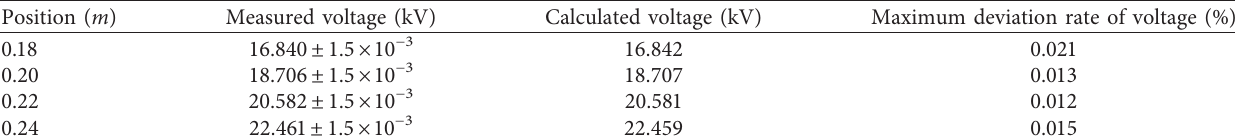
Table 1: Comparison of calculated and measured voltages at four different medium-voltage tap positions.